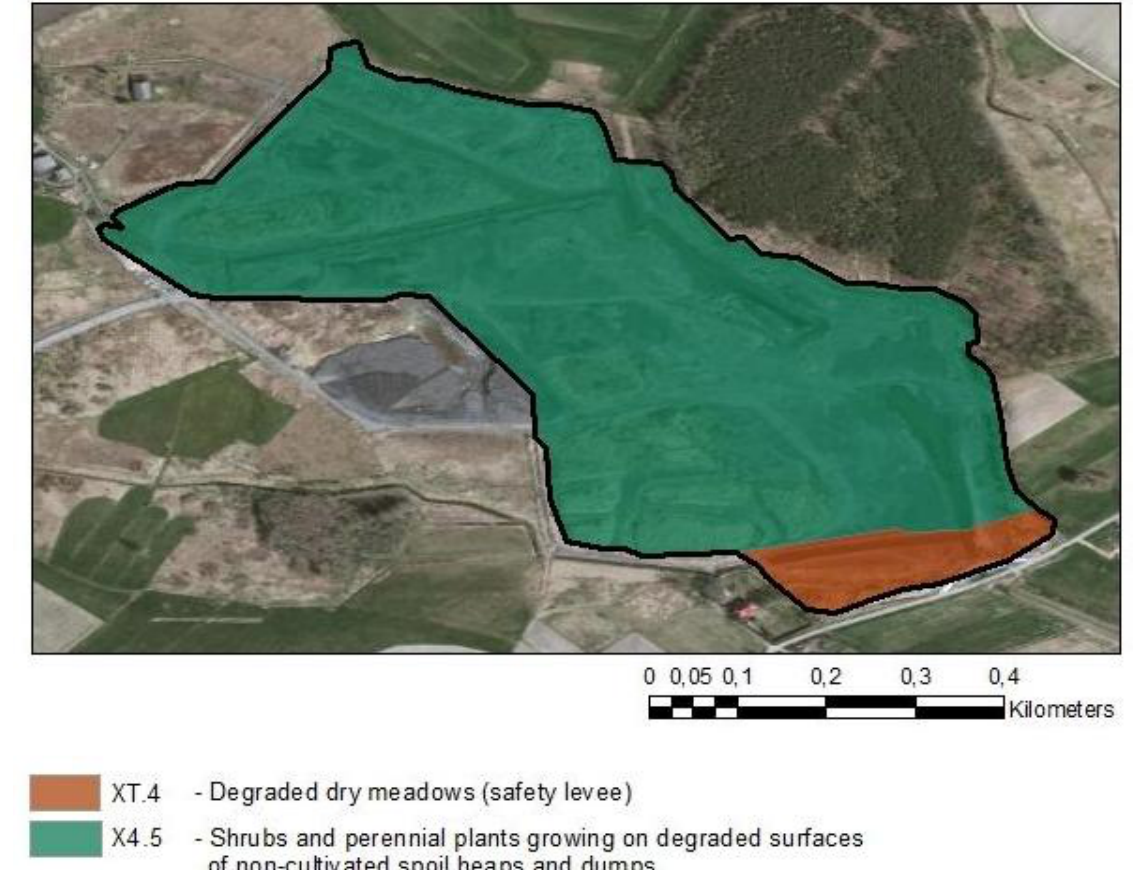
Fig. 3. Distribution of natural habitats occurring at present in the area of the flooded mining pit (source: WMS